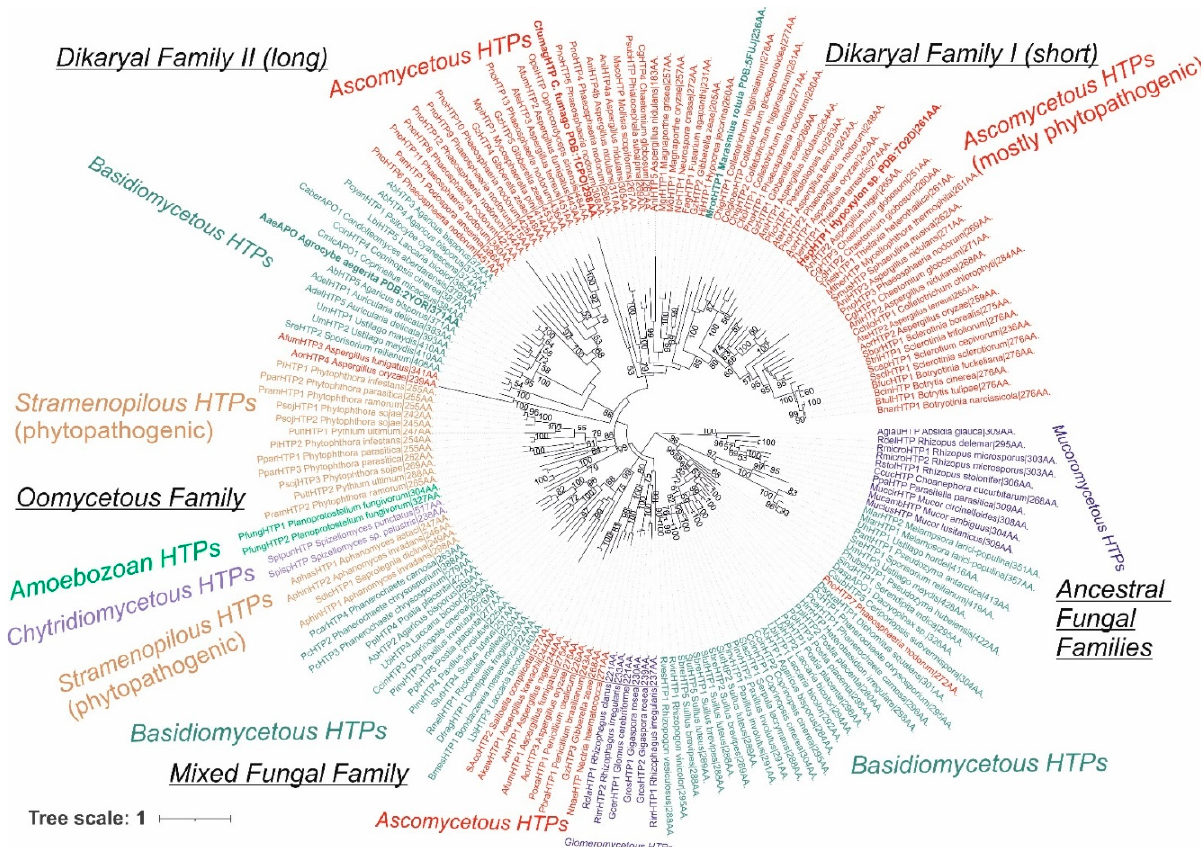
Figure 1. Global evolutionary tree for the peroxidase–peroxygenase superfamily obtained with the maximum likelihood method within the MEGA X suite [12] by using the Le_Gascuel model of amino acid substitution [14] and 1000 bootstrap replications. Only the distribution of phyla in major grouped clades are shown here schematically. Details of the topology for particular HTP sequences are presented in Figure 2.